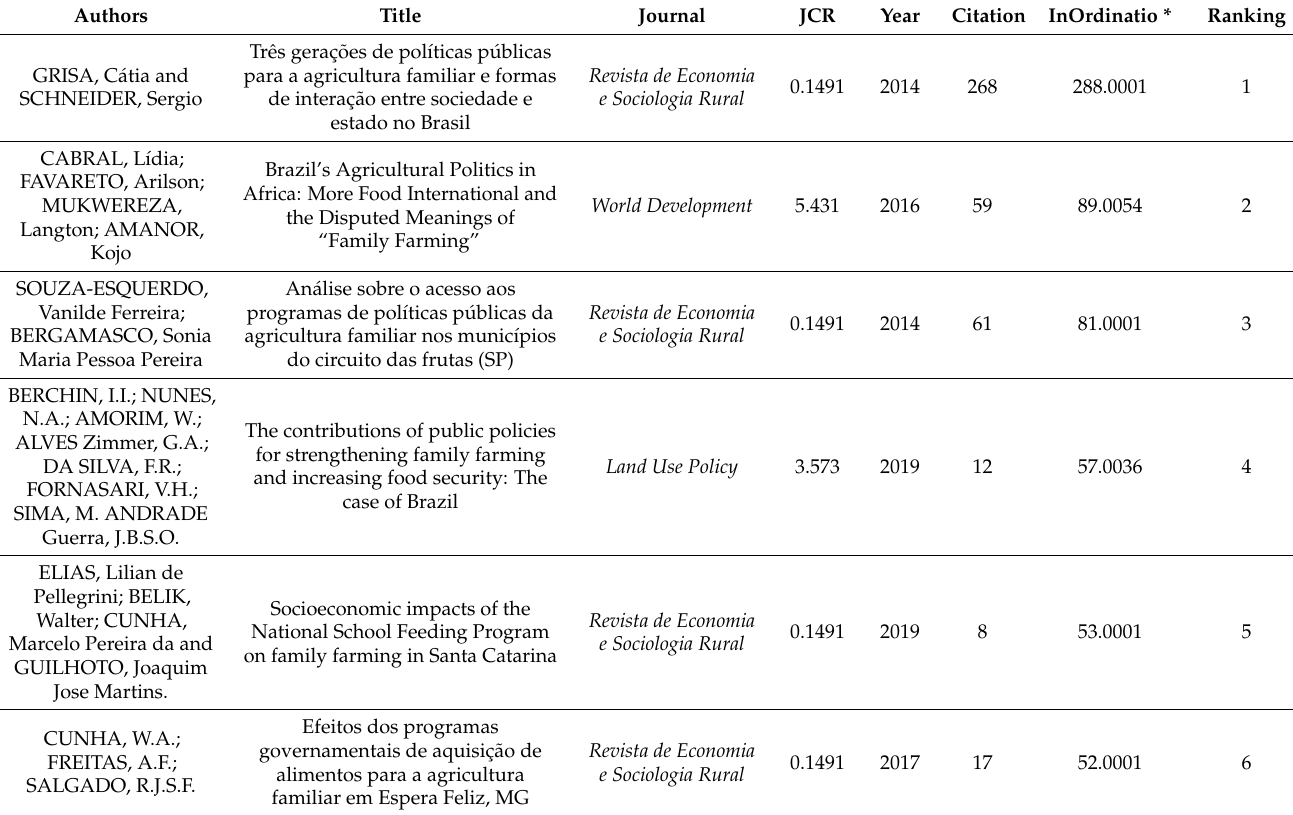
Table A2. Portfolio ranking with the application of the InOrdinatio